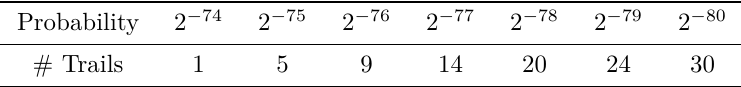
Table 5: Differential effect for 384